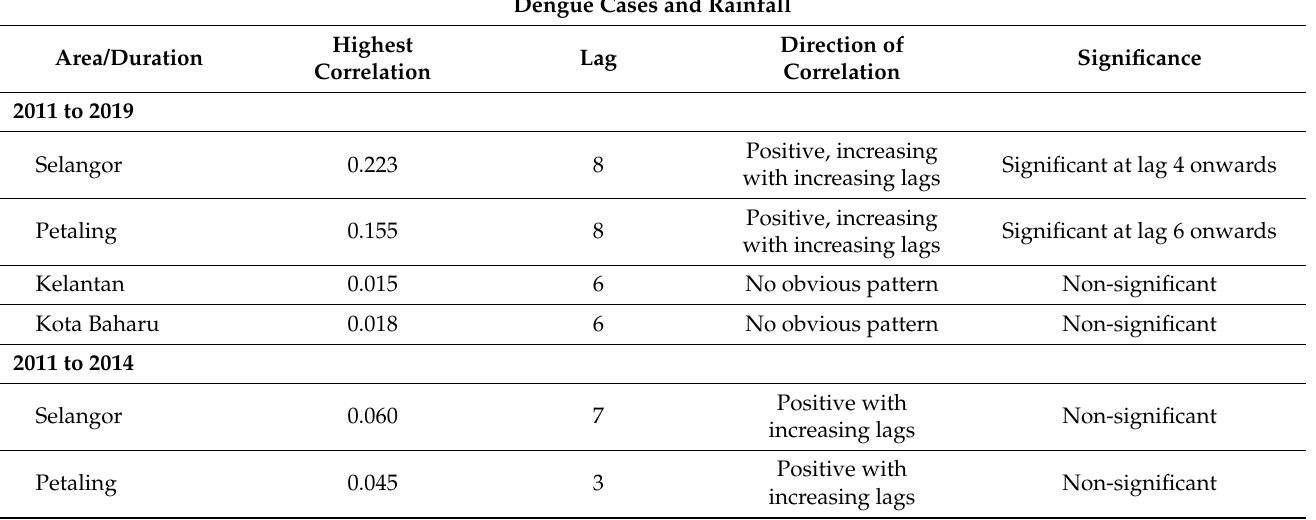
Table 3. Cross correlation estimates between dengue cases and EO-based meteorological data,